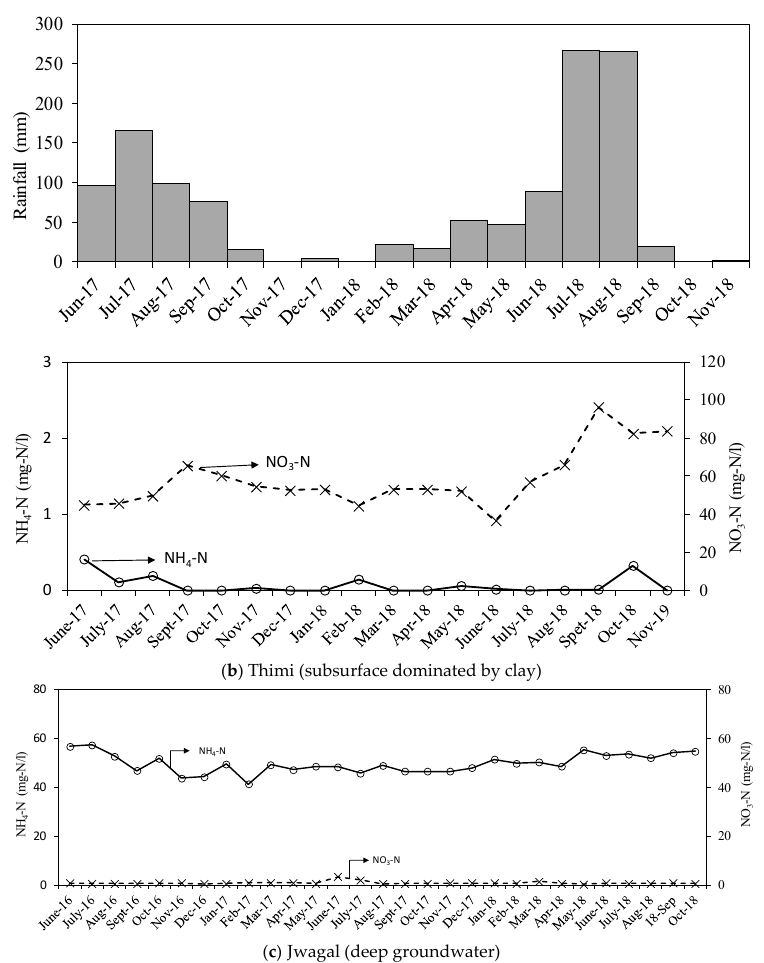
Figure 4. Monthly concentration variations in shallow groundwater from ( a ) Chyasal and ( b ) Thimi and ( c ) in deep groundwater from Jwagal compared with the rainfall data of the areas. Table 3. Distributions of stable isotopes of oxygen and nitrogen from nitrate in Chyasal and Thimi. 𝛿 15 N-NO 3 (‰) Location